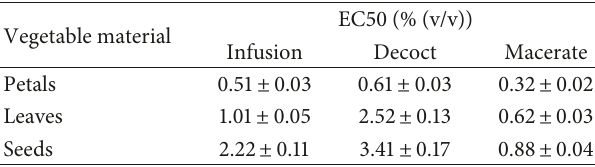
Table 4: Total antioxidant capacity of extracts obtained from different aerial parts of Rudbeckia triloba .